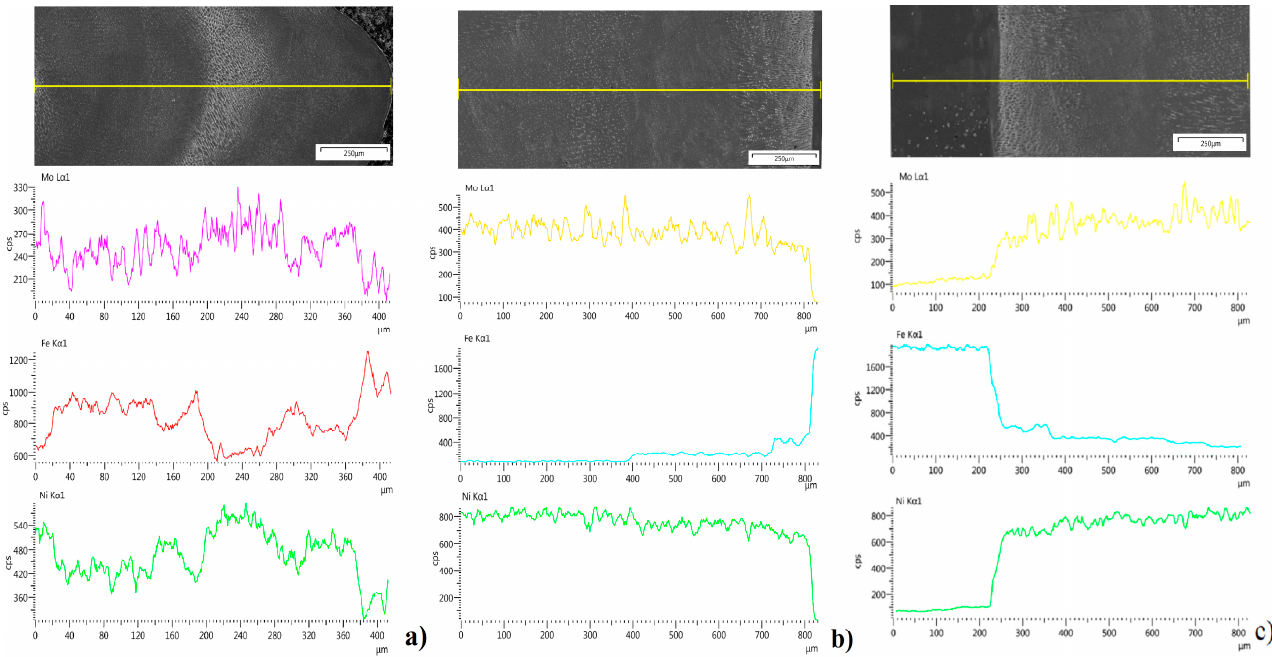
Figure 10. Distribution of Mo, Fe, and Ni in the fusion area: ( a ) wire deposition, ( b ) semi-hybrid deposition, ( c ) powder deposition method.